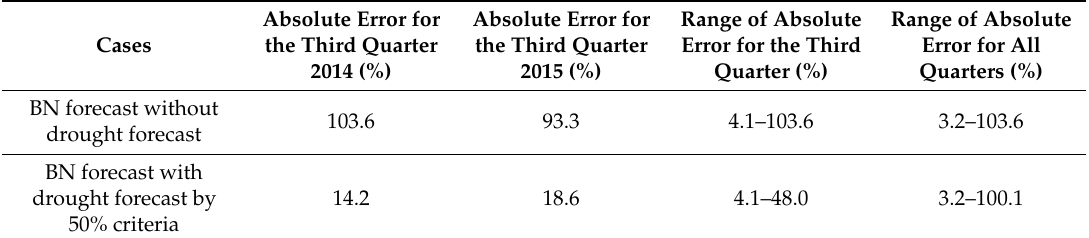
Table 5. Quarterly inflow forecasting errors for the Soyanggang dam.